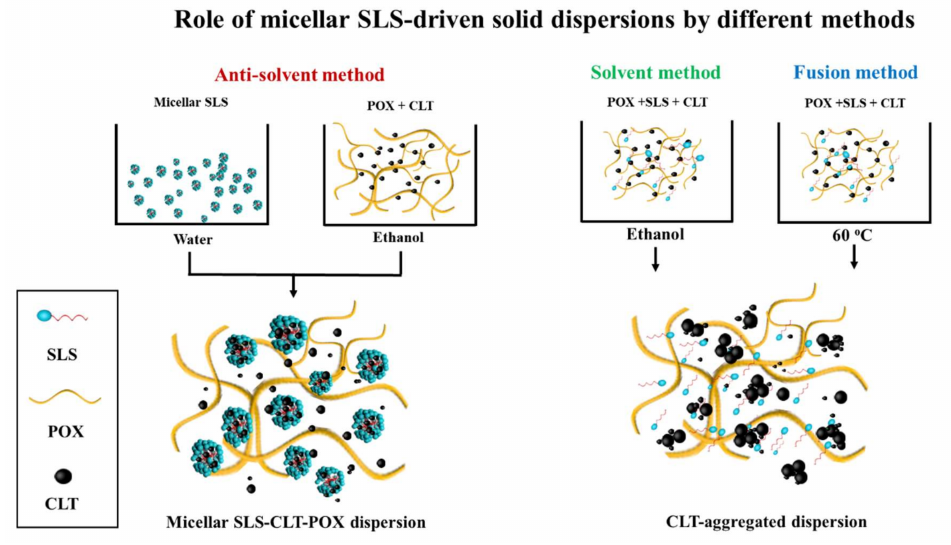
Figure 7. Schematic diagram of the role of micellar SLS-driven solid dispersion by different methods, showing dissolution enhancement of the anti-solvent